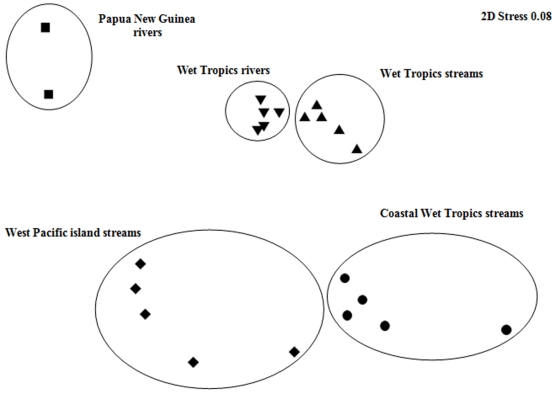
MDS ordination of West Pacific freshwater fish communities.Two-dimensional MDS ordination of freshwater fish assemblage presence/absence data for sub-regions of the West Pacific.